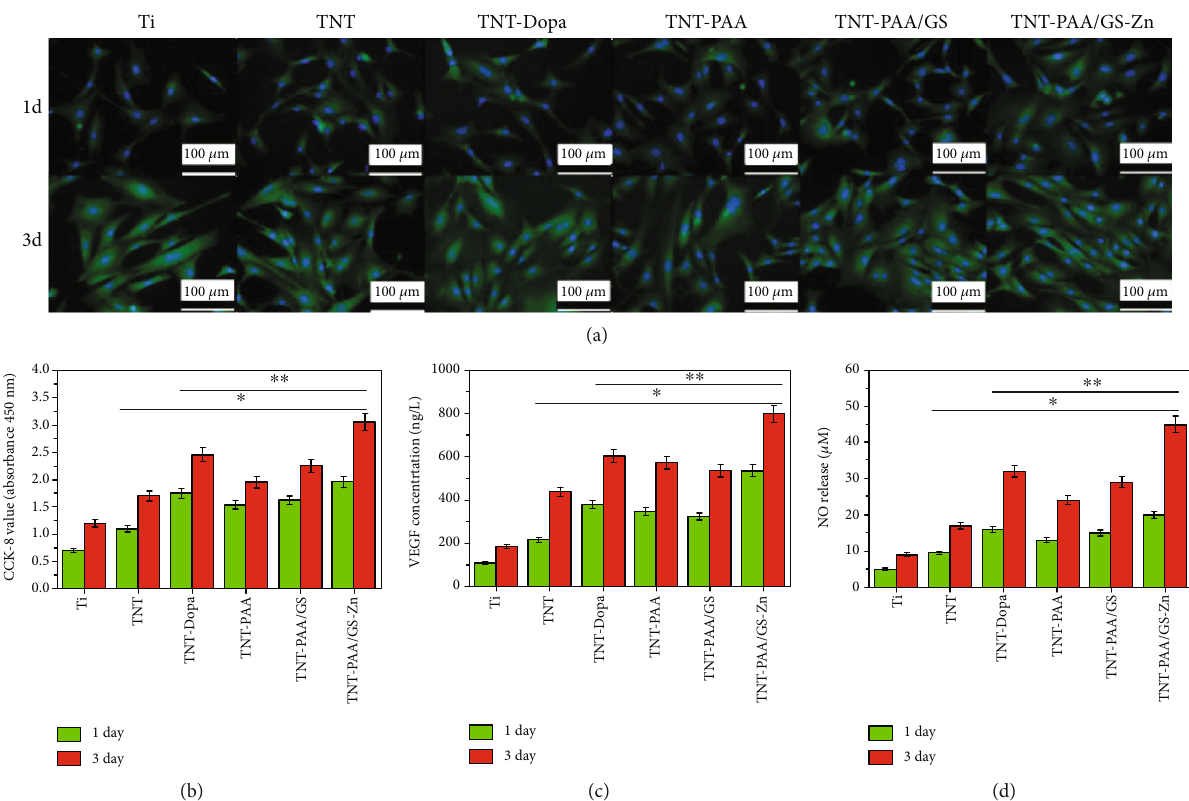
Figure 5: The fl uorescent pictures of endothelial cells adhered to the surfaces of di ff erent samples (a). CCK-8 values (b), VEGF (c), and NO (d) activities of endothelial cells grown on the di ff erent sample surfaces for 1 and 3 days, respectively. Statistical signi fi cance of p < 0 : 05 is indicated by ∗ as compared with the Ti group and by ∗∗ as compared with the Ti and TNT